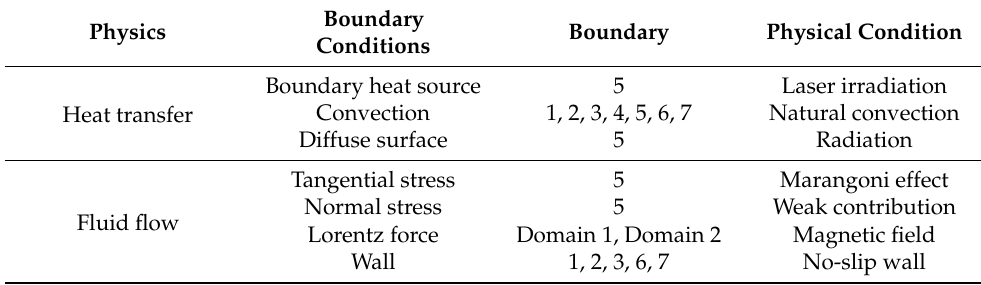
Table 1. Boundary conditions.